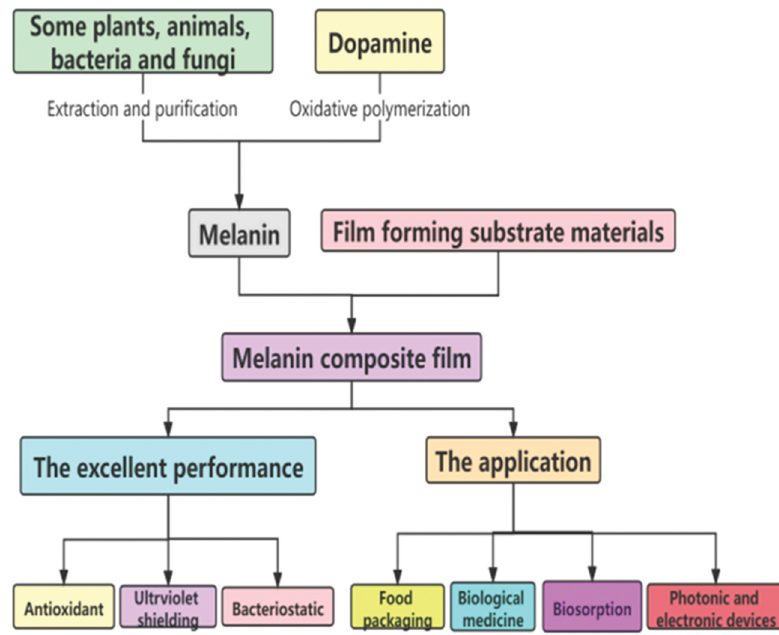
Figure 1: Preparation, properties and application of melanin composite fi